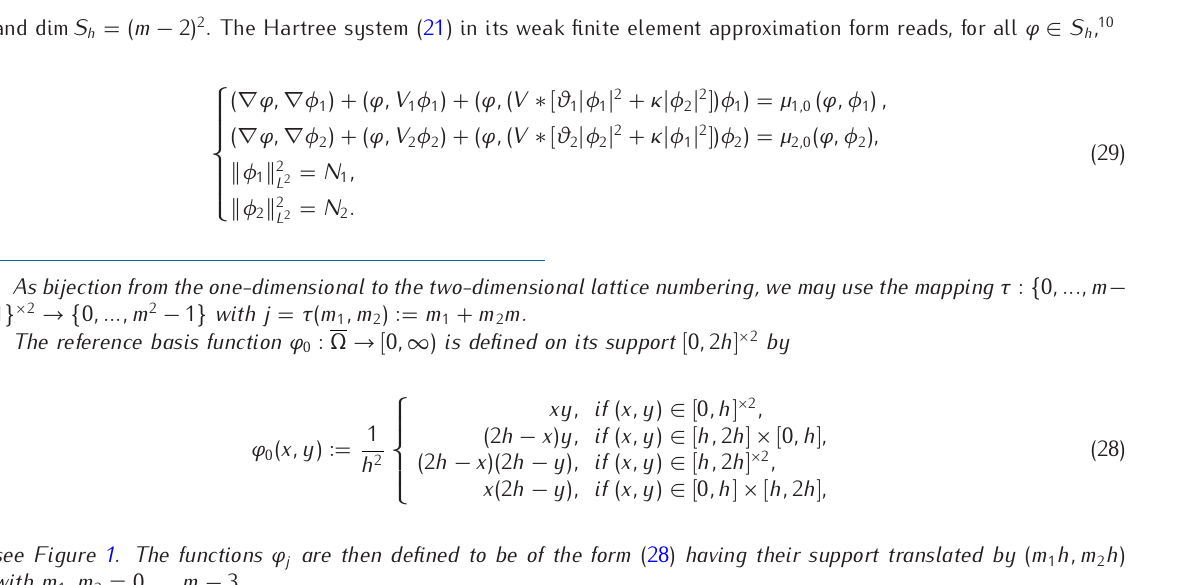
(Ω) S h ⊂ C (Ω) ∩ H 1 0